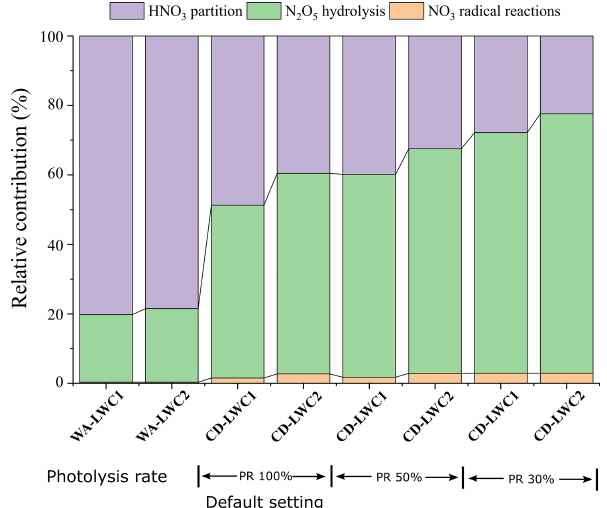
Figure 5. Relative contribution of each pathway to the nitrate pro- duction in wet aerosols (WAs; 0.5µm) and cloud droplets (CDs; 8µm), respectively, simulated by the RACM-CAPRAM. The at- mospheric conditions considered for comparison are LWC (10 − 5 – 10 − 4 gcm − 3 for wet aerosols and 0.05–0.15gcm − 3 ) and photoly- sis rates (30%, 50%,